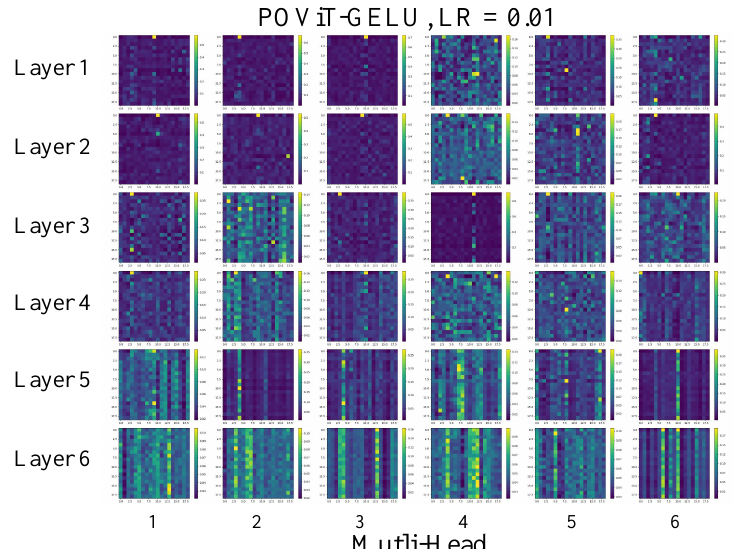
Figure 6. Heatmaps of self-attention in the six-layer POViT model. Learning rate was taken to be 0.01 and GELU was used as the activation